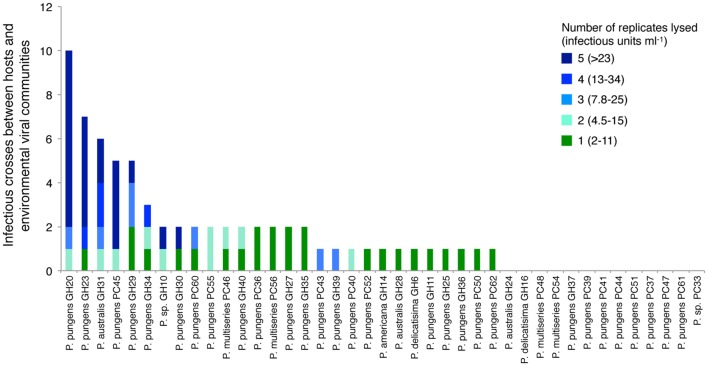
Total number of viral community samples that resulted in an infection for each host strain. Colors correspond to the number of replicates that were lysed and the corresponding range of infectious units based on most probable number tables for each infectious cross. Infectious units ml-1 of seawater were calculated assuming 100% retention of infectivity and accounting for the effect of concentrating virus from 20 L of seawater and volume of viral concentrates added to host cultures in crosses.